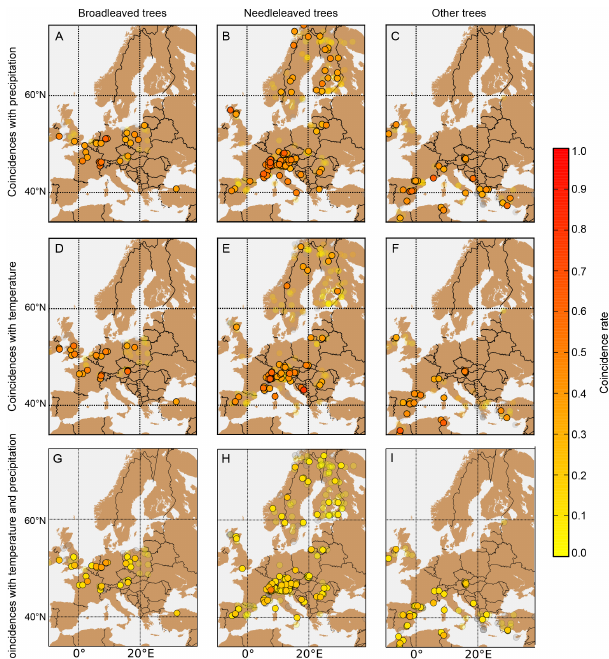
Figure 5. Map of tree ring sites and coincidence rates at each site. Coincidence rates between extremes in TRW and precipitation for (a) broadleaved, (b) needle-leaved and (c) other tree species are provided. In the middle row (d, e, f) , coincidence rates between extremes in TRW and temperature for the different tree species are displayed. In the lower row (g, h, i) , coincidence rates for extremes in TRW and combined precipitation and temperature extremes are given. Nonsignificant sites are marked with transparent dots. The colour bar gives the coincidence rate r for the coincidence analysis with (cid:49)t = 2.